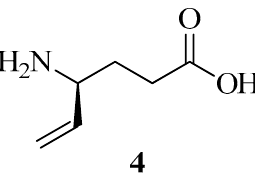
Figure 2. Vigabatrin, an inactivator of GABA-AT.